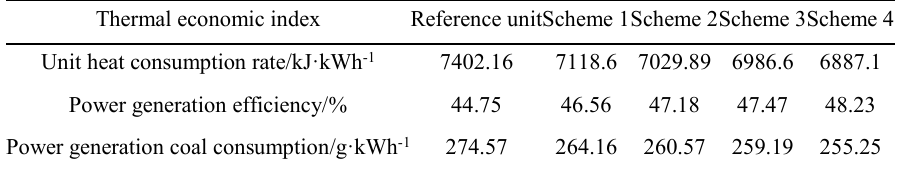
Table 3. Comparison of energy saving effects of different heat recovery series